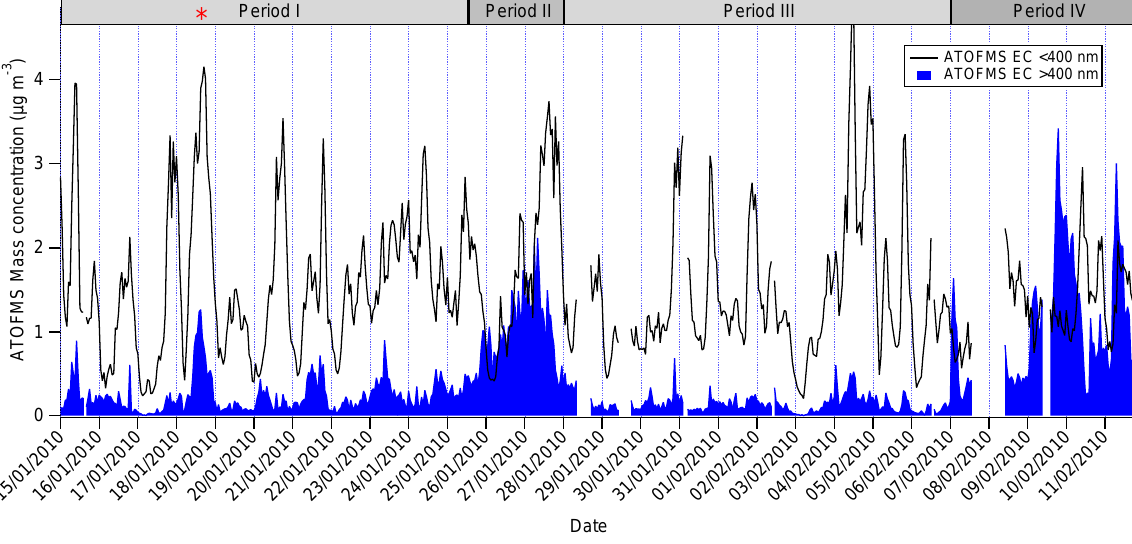
Fig. 10. Hourly scaled ATOFMS EC particle mass concentration for particles less than and greater than 400nm in